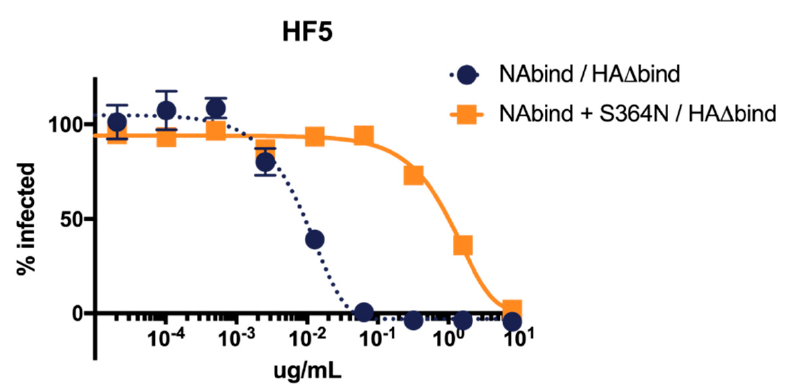
Figure 3. S364N increases resistance to neutralization by antibody HF5 in single-cycle infections for viruses that are dependent on NA for receptor-binding. Results are shown as the percent infection at each concentration compared to the no-antibody infection control. Points represent the mean of three technical replicates with error bars showing the standard error of the mean.